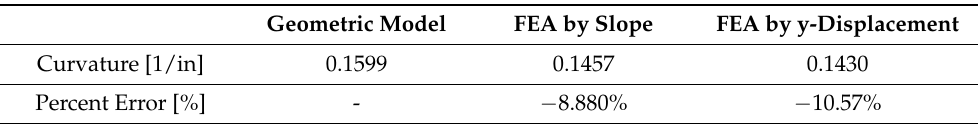
Figure 5. FEA simulation result. ( a ) Average von Mises strain of a fish scale model with 4-inch length, 2-inch spacing, and 30-degree angle. ( b ) Average von Mises stress of a fish scale model with 4-inch length, 2-inch spacing, and 30-degree angle. ( c ) Comparison plot between geometric and FEA results. Table 1. Comparison between geometric and FEA results using a fish scale model with a scale length of 4 inches, scale spacing of 2 inches, and angle of 30